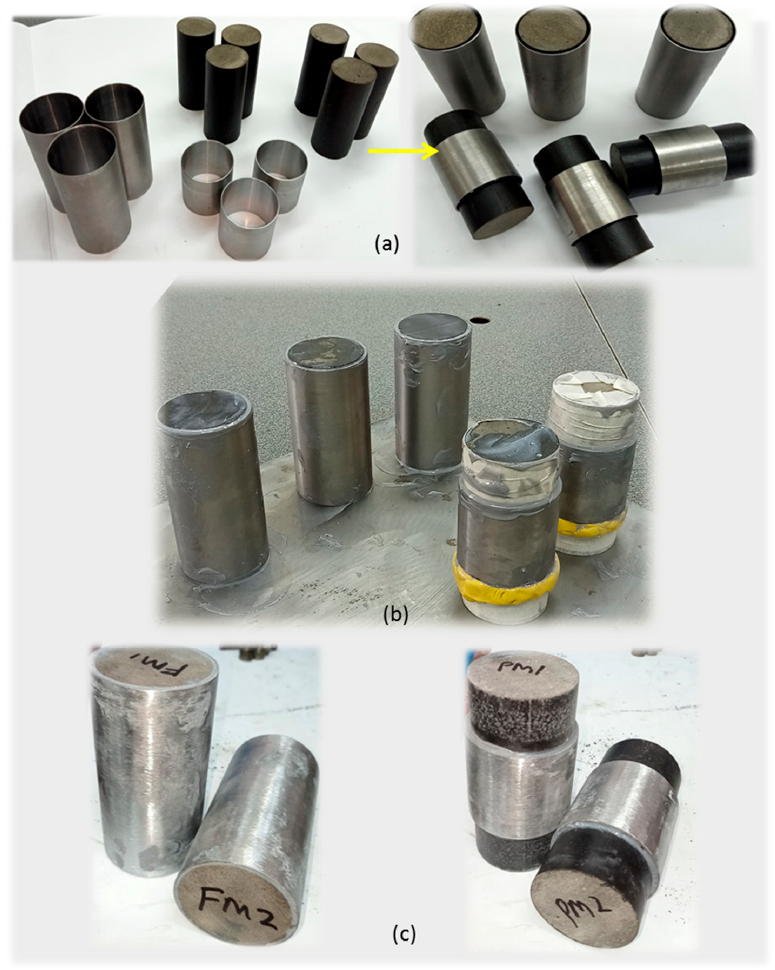
Figure 5. Specimen fabrication process. ( a ) Metal tube ready to confine the TSPC column. ( b ) Application of Sikadur 330 adhesive and curing of TSPC with metal tube confinement (binder thickness 0.5–1.0 mm). ( c ) Finished samples consist of TSPC with full and partial metal tube confinement